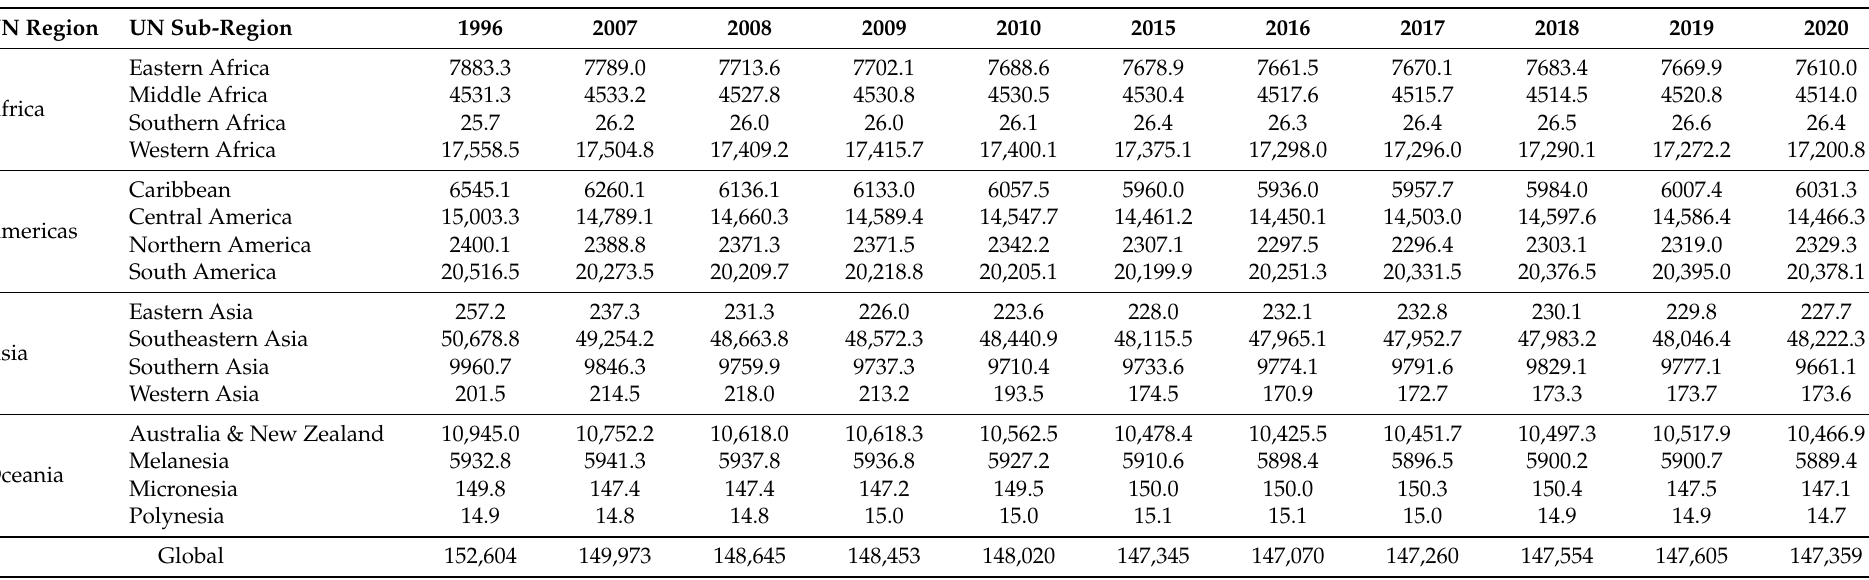
Table 6. Mangrove extent estimates 1996–2020 for the UN Statistics geographic regions in km 2 . Individual country statistics are within Appendix A. Note: reported mangrove extent estimates account for known map commission and omission